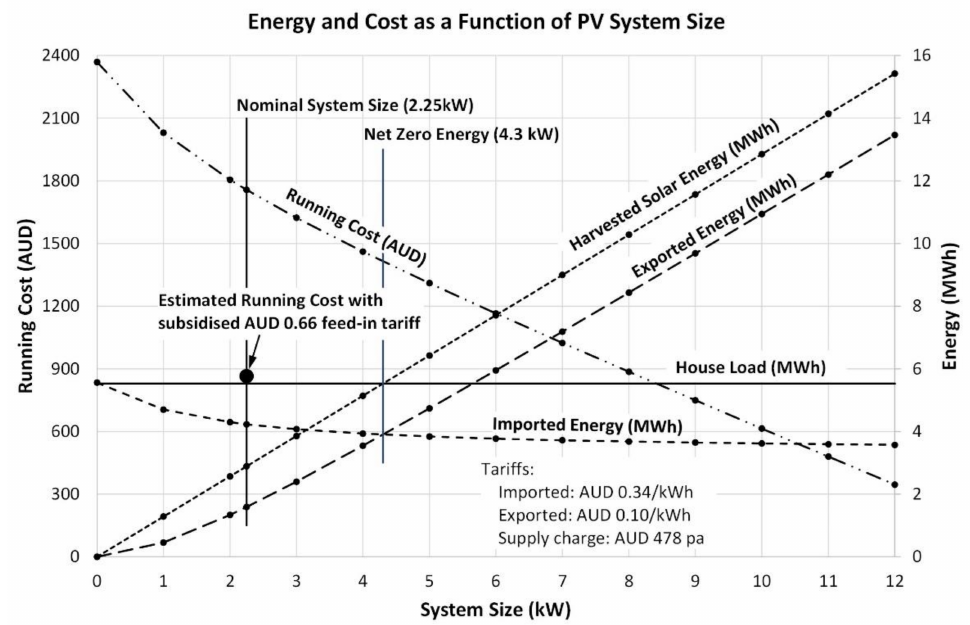
Figure 6. House 2: Energy flows and cost of electricity as a function of Solar PV system